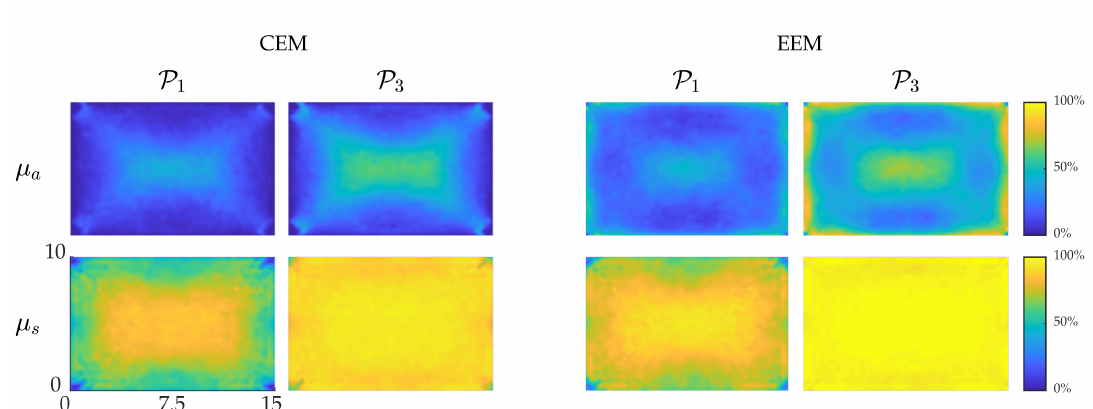
Figure 8. Percentages of true values of parameters in each node which lie in the interval [ ˆ µ − σ ˆ µ , ˆ µ + σ ˆ µ ] ( first column ) and interval [ ˆ µ − 3 σ ˆ µ , ˆ µ + 3 σ ˆ µ ] ( second column ) in the MAP-CEM reconstructions. Percentages of true values of parameters in each node which lie in the interval [ ˆ µ − σ ˆ µ , ˆ µ + σ ˆ µ ] ( third column ) and interval [ ˆ µ − 3 σ ˆ µ , ˆ µ + 3 σ ˆ µ ] ( fourth column ) in the MAP-EEM reconstructions. First row presents the absorption coefficient and second row the scattering coefficient. Reference values for true Gaussian distribution are P 1 = 68.2% and P 3 = 99.7%. The units of axes are in